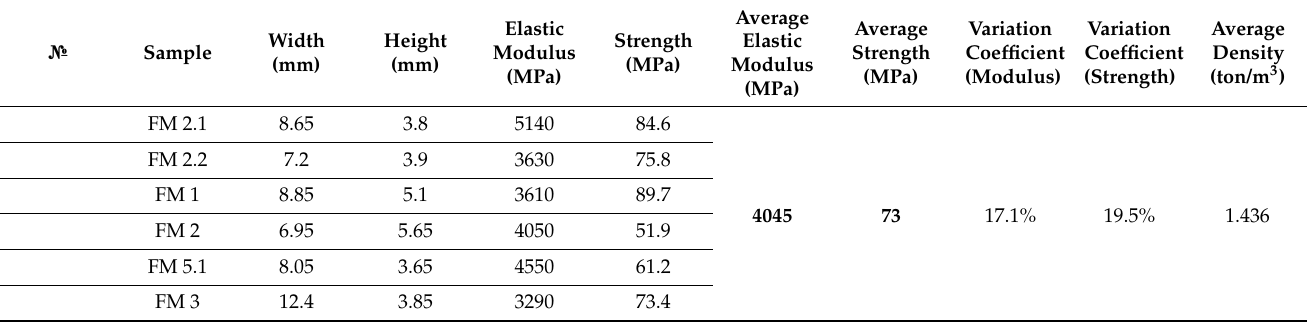
Table A29. Three-point bending test results at 23 ◦ C of filled binder